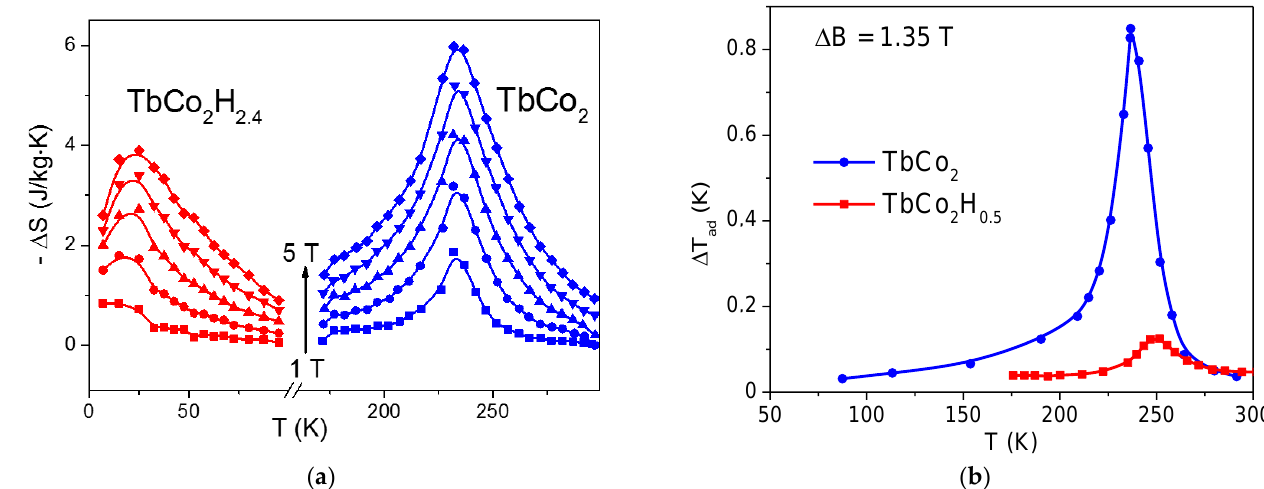
Figure 5. Temperature dependences of the change in the magnetic part of the entropy at various changes in the magnetic field (from 0 to 1 – 5 T) in the TbCo 2 H 2.4 hydride and the initial composition TbCo 2 ( a ); Temperature dependences of the MCE at ΔB = 1.35 T measured by the direct method of TbCo 2 H 0.5 and the initial composition TbCo 2 ( b ).